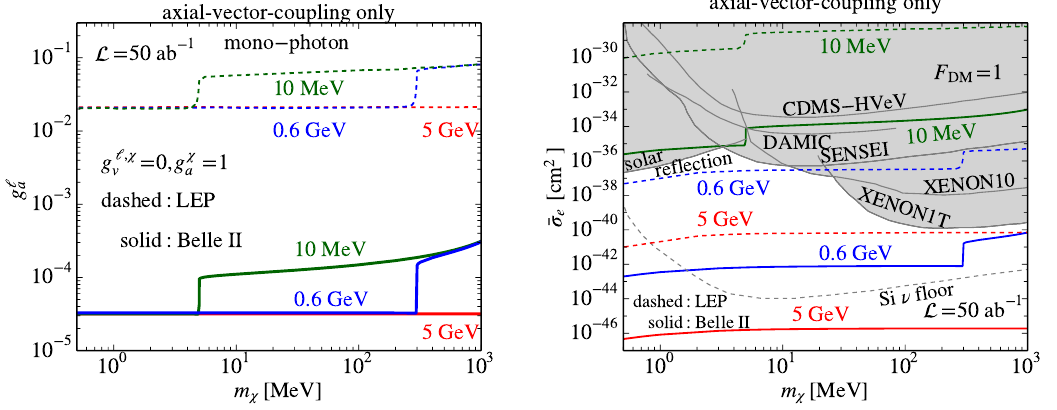
Figure 2 . The expected Belle II 90% upper bound (solid lines) with 50 ab − 1 integrated luminosity on g ‘ (left panel) and ¯ σ (right panel) in light mediator models where only vector couplings are e v assumed. Three Z 0 masses are considered for the Belle II analysis: m 0 . 6 GeV (blue), and m = 10 MeV (green). The LEP constraints (dashed lines) with 650 pb − 1 Z 0 integrated luminosity are also shown for three Z 0 masses. Constraints from DMDD experiments with F DM ( q ) = 1 (valid for m Z 0 (cid:29) αm e ) are also shown: SENSEI [74], XENON10 [5] and XENON1T [6], CDMS-HVeV [72], DAMIC [73], and solar reflection [22]. The gray dashed line shows the neutrino floor limit for silicon detectors [75].